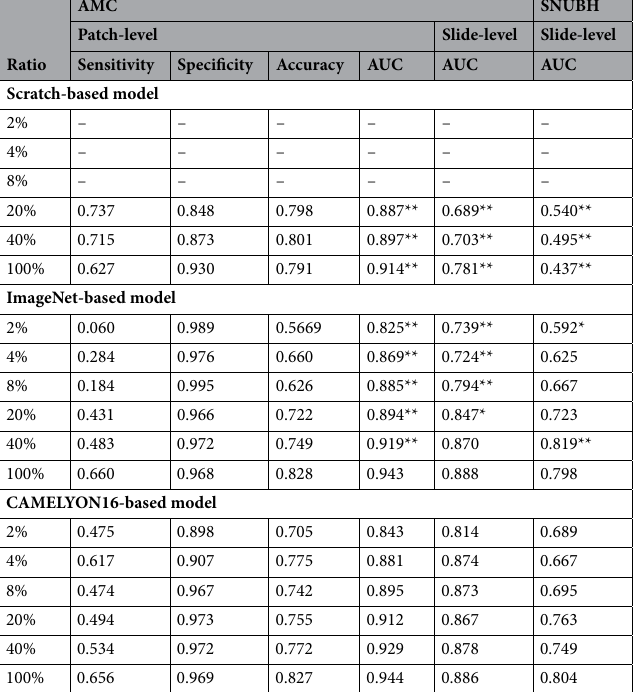
Table 2. Performance comparison of models based on different initial weights for different ratios of the training dataset. In the AMC dataset, sensitivity, specificity, and accuracy at threshold 0.5, and AUC were measured for patch-level evaluation and AUC for slide-level evaluation was measured on AMC and SNUBH datasets. Statistical comparisons between AUCs of CAMELYON16-based model and others trained with the same ratio of the training dataset were performed to determine whether the model’s performance with different initial weights were significant. AMC, Asan Medical Center; SNUBH, Seoul National